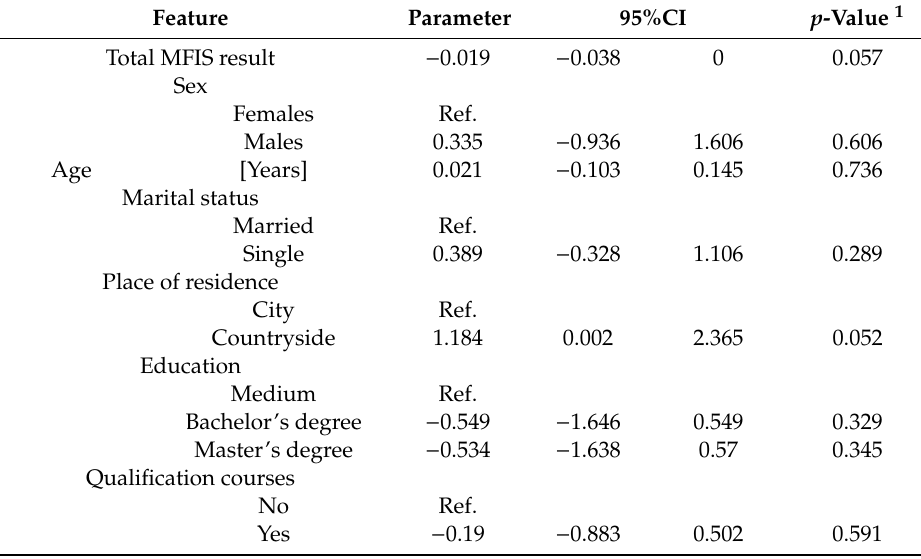
Table 6. The regression model and rationing of job satisfaction